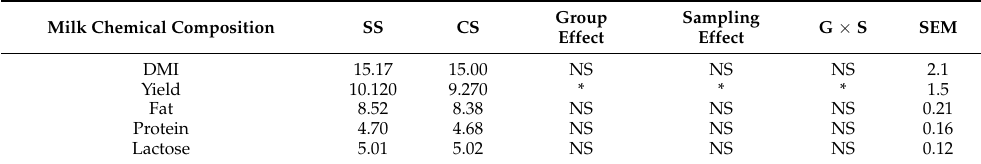
Table 4. Daily dry matter intake (DMI, kg DM/head/day), milk yield (kg/head/day) and chemical composition (%).